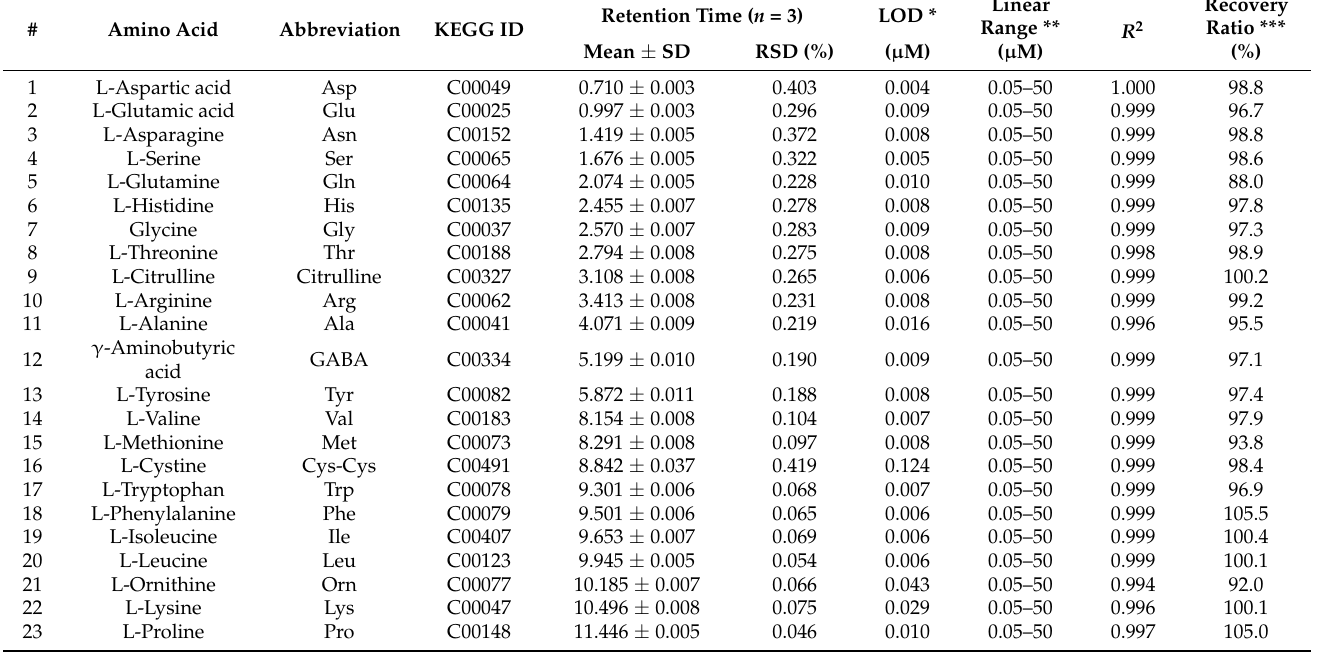
Table 1. System validation using standard